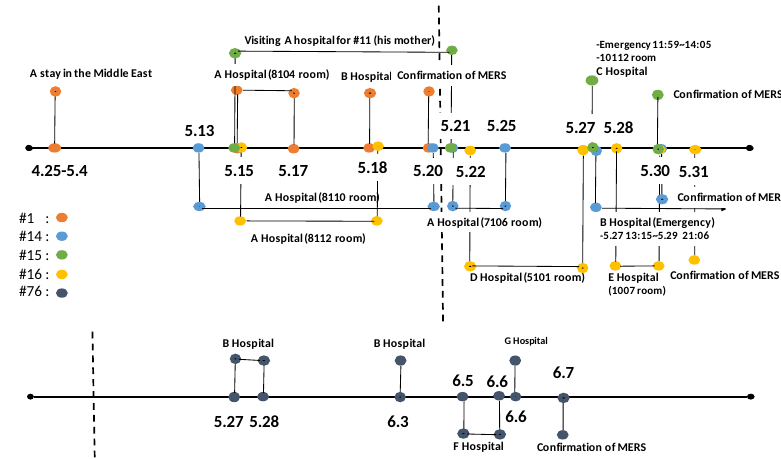
Figure 4. Multiple visits of the five superspreaders are displayed: the index case is shown with an orange circle, patient #14 is shown with a blue circle, patient #15 is shown with a green circle, patient #16 is shown with a yellow circle, and patient #76 is shown with a dark gray circle. The vertical dashed line indicates the date that the index case was confirmed on May